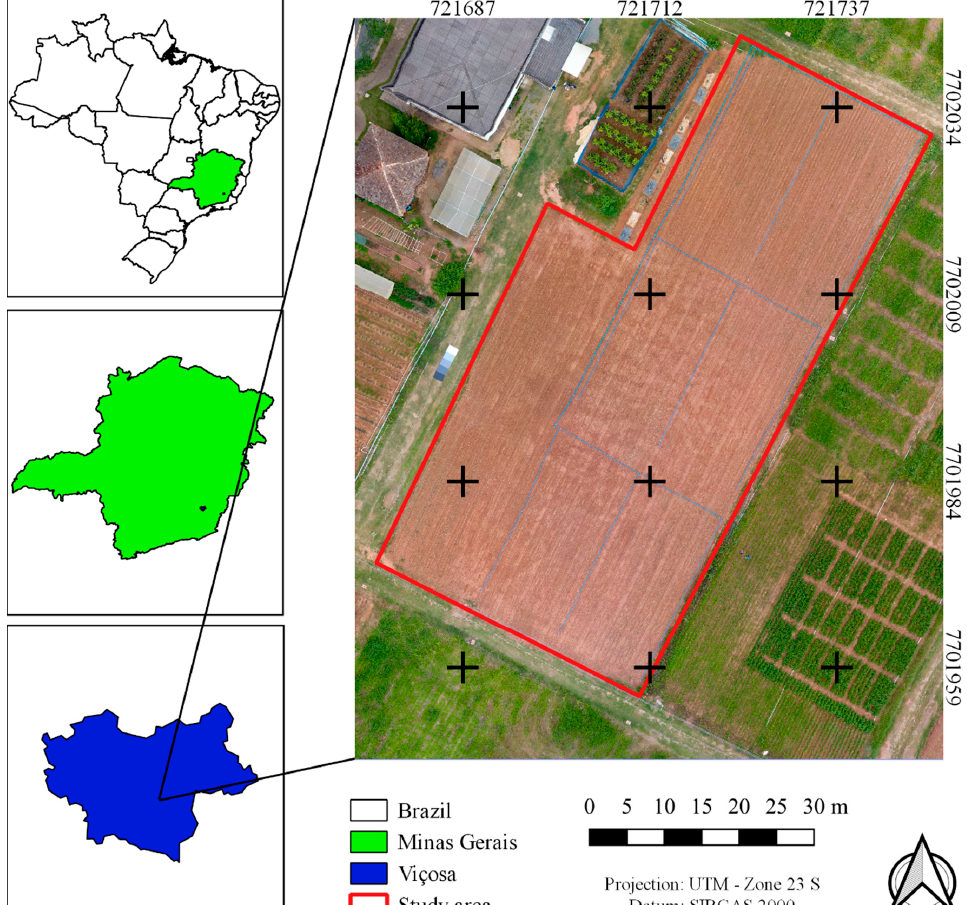
Figure 1. Location of the study area in relation to the municipality of Viçosa, Minas Gerais state, and Brazil.